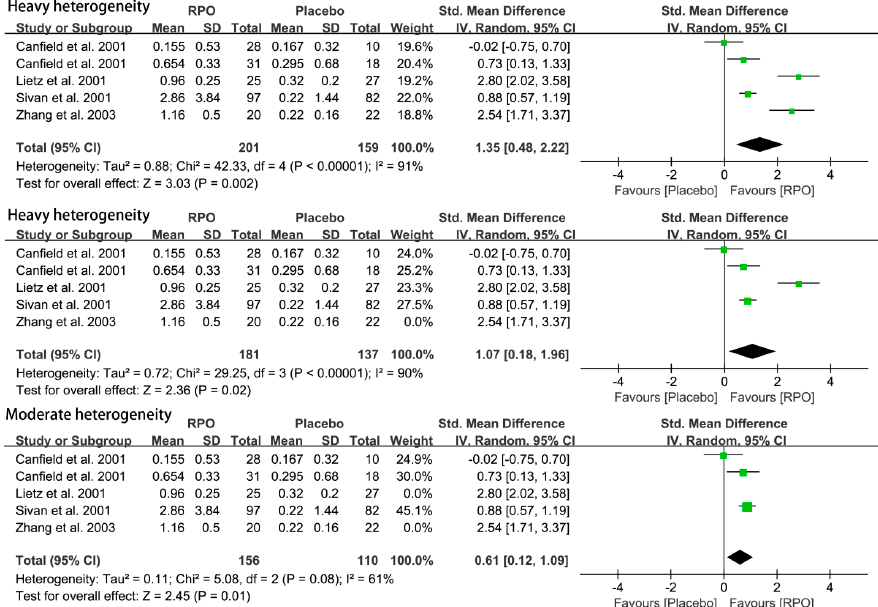
Figure 5. Forest plot of the effect of red palm oil (RPO) intervention on serum β -carotene levels ( μ mol/L) (RPO group vs. placebo group). CI: confidence interval.